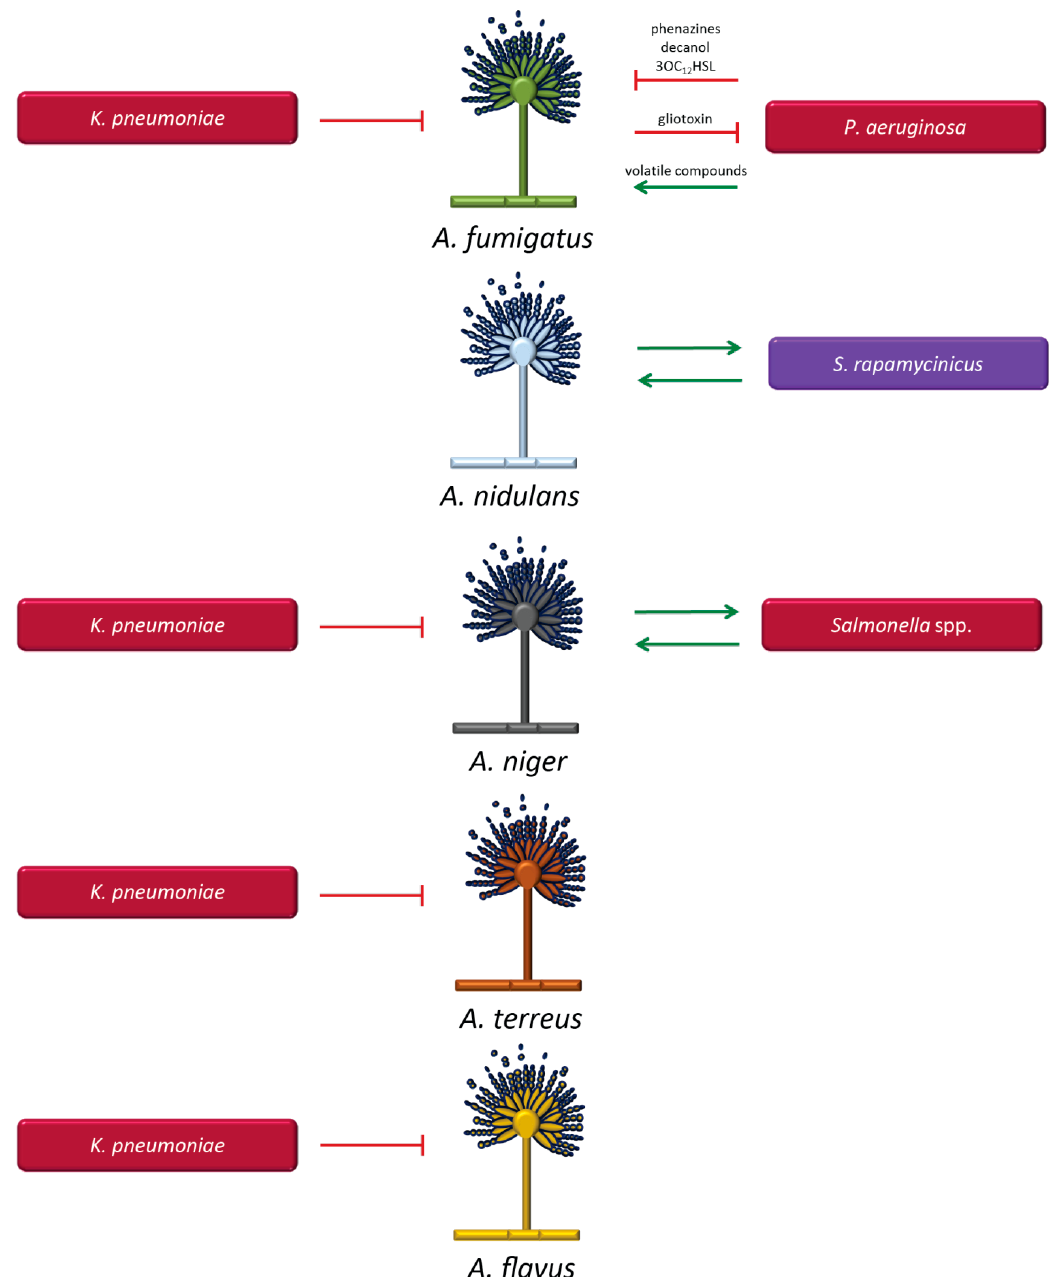
Figure 2. Molecules and factors mediating the interaction between Aspergillus species and bacteria. Aspergillus species include Aspergillus (A.) fumigatus , Aspergillus (A.) nidulans , Aspergillus (A.) niger , Aspergillus (A.) terreus and Aspergillus (A.) flavus . Gram-positive bacteria are represented in lilac ( Streptomyces (S.) rapamycinicus ) and Gram-negative bacteria in red ( Klebsiella (K.) pneumoniae , Pseudomonas (P.) aeruginosa ). Green arrows indicate supportive interactions and red lines represent inhibitory effects. If not indicated above the green arrows and red lines, the molecules mediating the interaction are currently unknown.